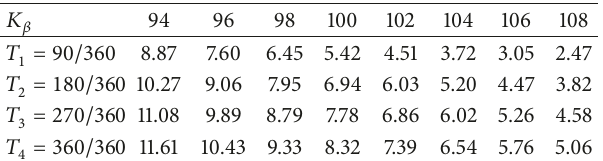
Table 2: Generated European call option prices for different strike prices 𝐾 𝛽 .